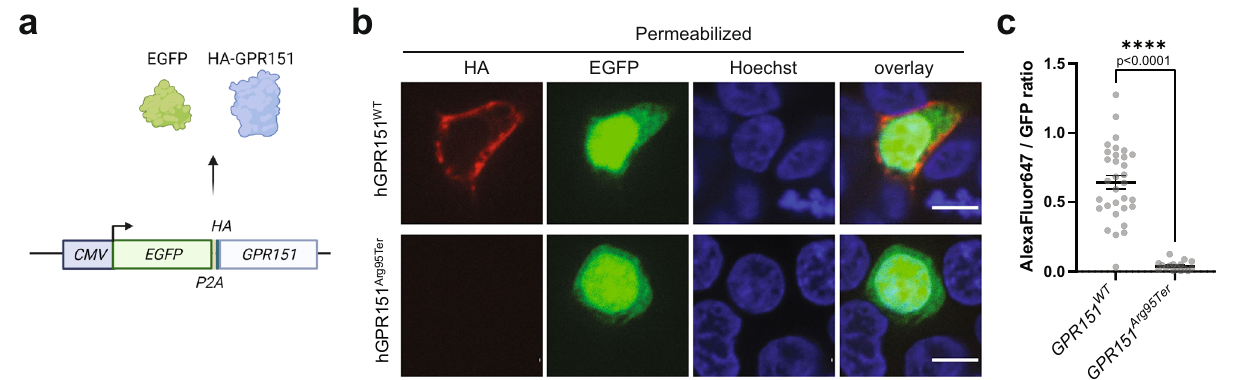
Fig. 7 | Cellular localization of the wild-type and p.Arg95Ter GPR151. a Schematicof the overexpression plasmids used.EGFP and HA-taggedGPR151 are produced in equal ratio from a single transcript. Image created using Biorender. b Confocal images of EGFP-positiveHEK293Tcellsthatweretransfected with each of the plasmids, fi xed, permeabilized and fl uorescently stained against the HA tag. Results of one experiment representative for three independent